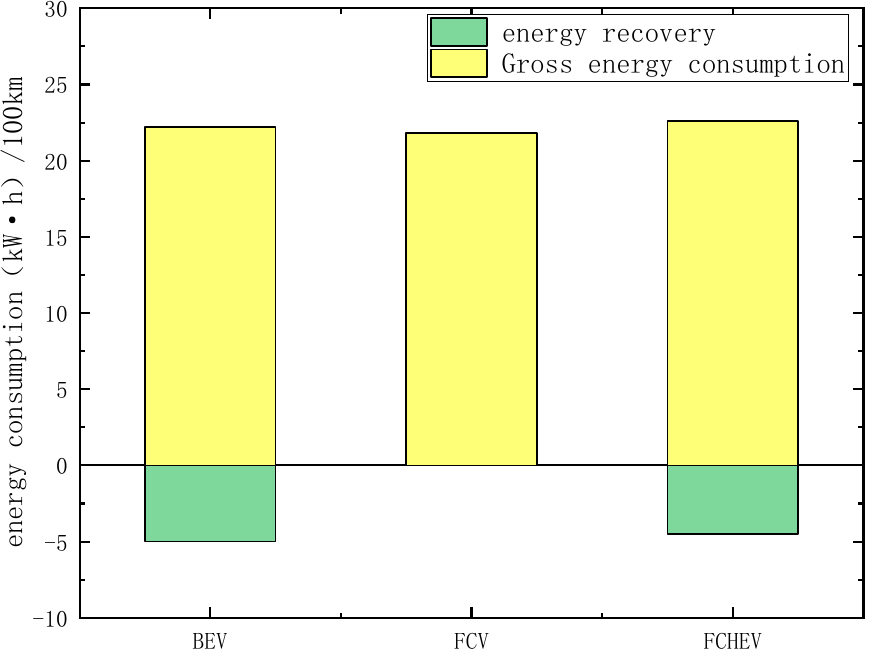
Figure 6. Energy consumption of three models under CLTC-P.